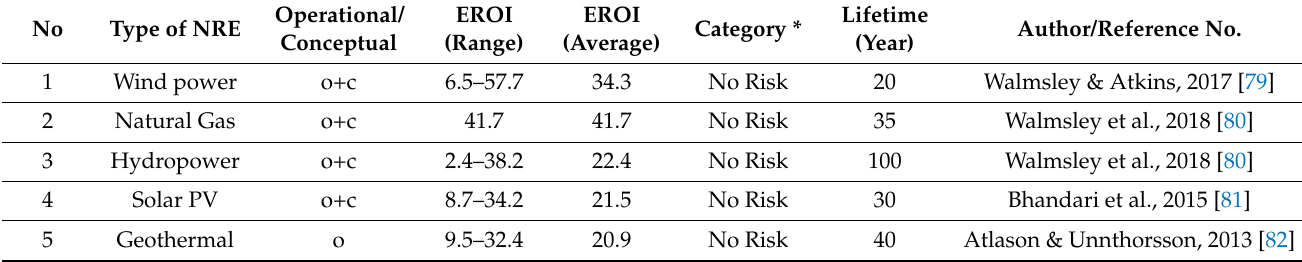
Table 3. EROI, lifetime, and category of other new and renewable energy (NRE)